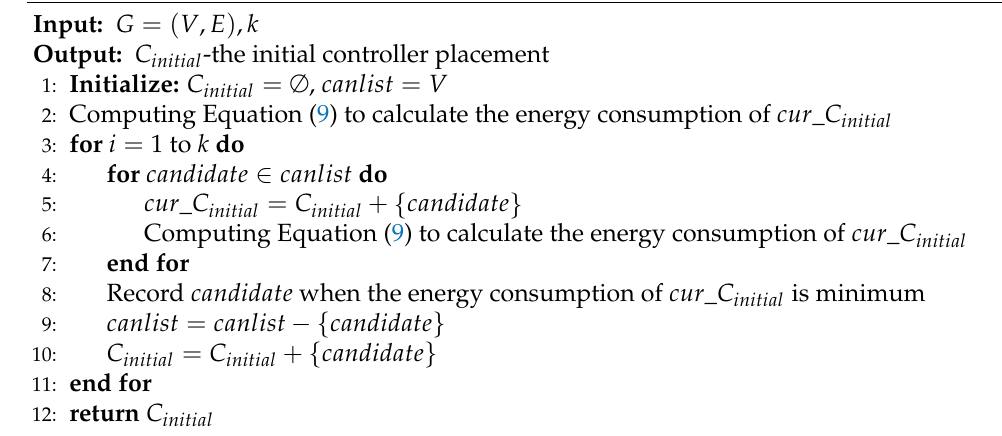
Algorithm 1 Greedy Initial Algorithm